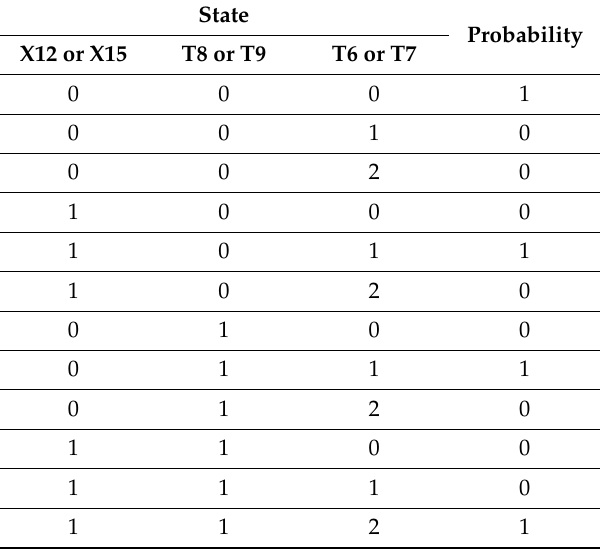
Table A2. CPT for T6 and T7.